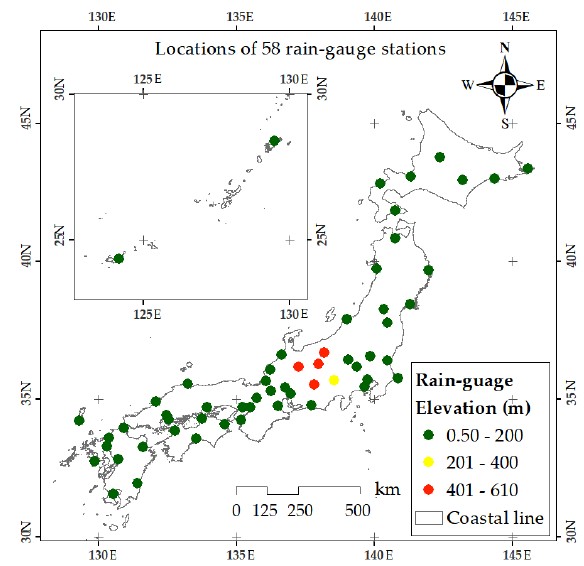
Figure 1. Locations of 58 rain-gauge stations. Colors indicate the elevation of each rain gauge.